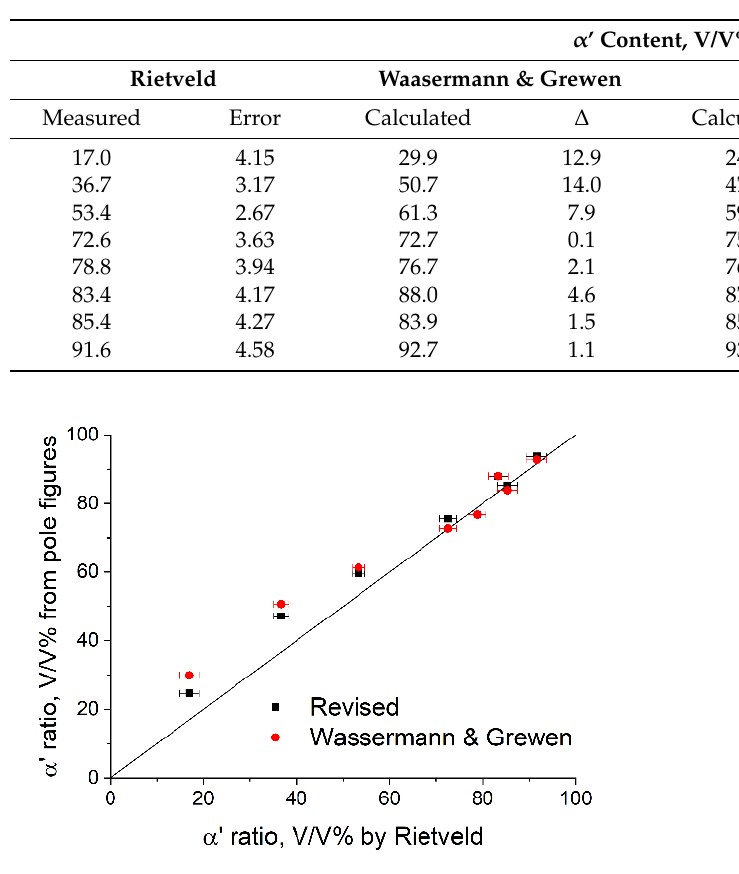
Table 2. The relative amount of α’ martensite in the prepared mixtures, determined by the Rietveld method, Wassermann and Grewen’s formula , and the revised formula, V/V%.